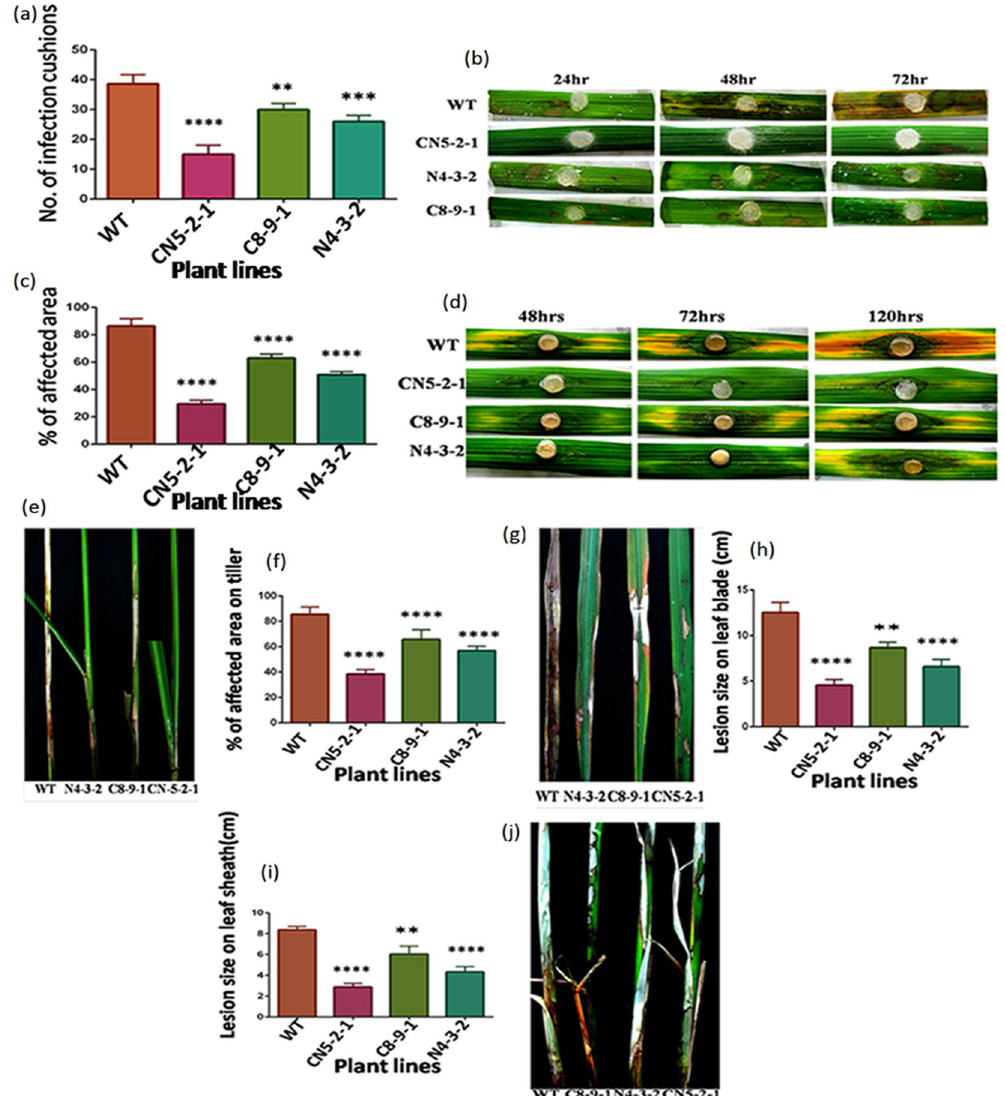
Figure 5. Evaluation of T 2 transgenic lines against sheath blight disease along with non-transformed control through In vitro and In vivo plant bioassay. ( a ) Mycellial agar disc bioassay showing reduced infection cushion formation in T 2 transgenic lines (CN5-2-1, N4-3-2, C8-9-1) than in the wild-type (WT). Experiments replicated three times. ( b ) Representative images of reduced lesion formation in transgenic leaves (CN5-2-1, N4-3-2, and C8-9-1) relative to WT in mycellial agar disc bioassay. ( c ) Bar diagram showing percentage of affected area after 72 hrs post infection in transgenic leaf samples than wild type (WT) in RS -toxin bioassay. ( d ) Images showing less affected area in transgenic leaves (CN5-2-1, C8-9-1, and N4-3-2) compared to WT control in the toxin bioassay. ( e ) Image showing reduced sheath blight symptoms development in rice tillers in T 2 transgenic plants, than that in WT control after 21 dpi (Days post infection). ( f ) Percentage of infected area on tillers on T 2 transgenic (CN5-2-1, C8-9-1, and N4-3-2) and WT plants after 21 dpi. ( g ) Images showing sheath blight symptoms on leaf blade of transgenic (CN5-2-1, C8-9-1, and N4-3-2) and non-transformed control. ( h ) Lesion size on leaf blade of WT and transgenic lines after 21 dpi. ( i ) Lesion size on leaf sheath of both WT and transgenic lines (CN5-2-1, C8-9-1, and N4-3-2) after 21 dpi. Values are presented as mean of 10 replicas ± SE. ( j ) Representative images showing reduction in symptoms development on rice sheath of transgenic lines as compared to WT after 21